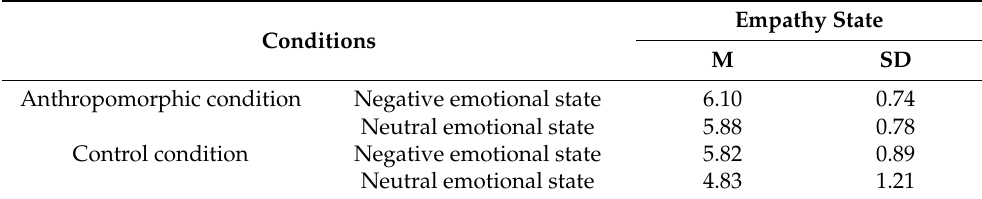
Table 6. The interaction effect of anthropomorphism and negative and neutral emotion states on empathy.